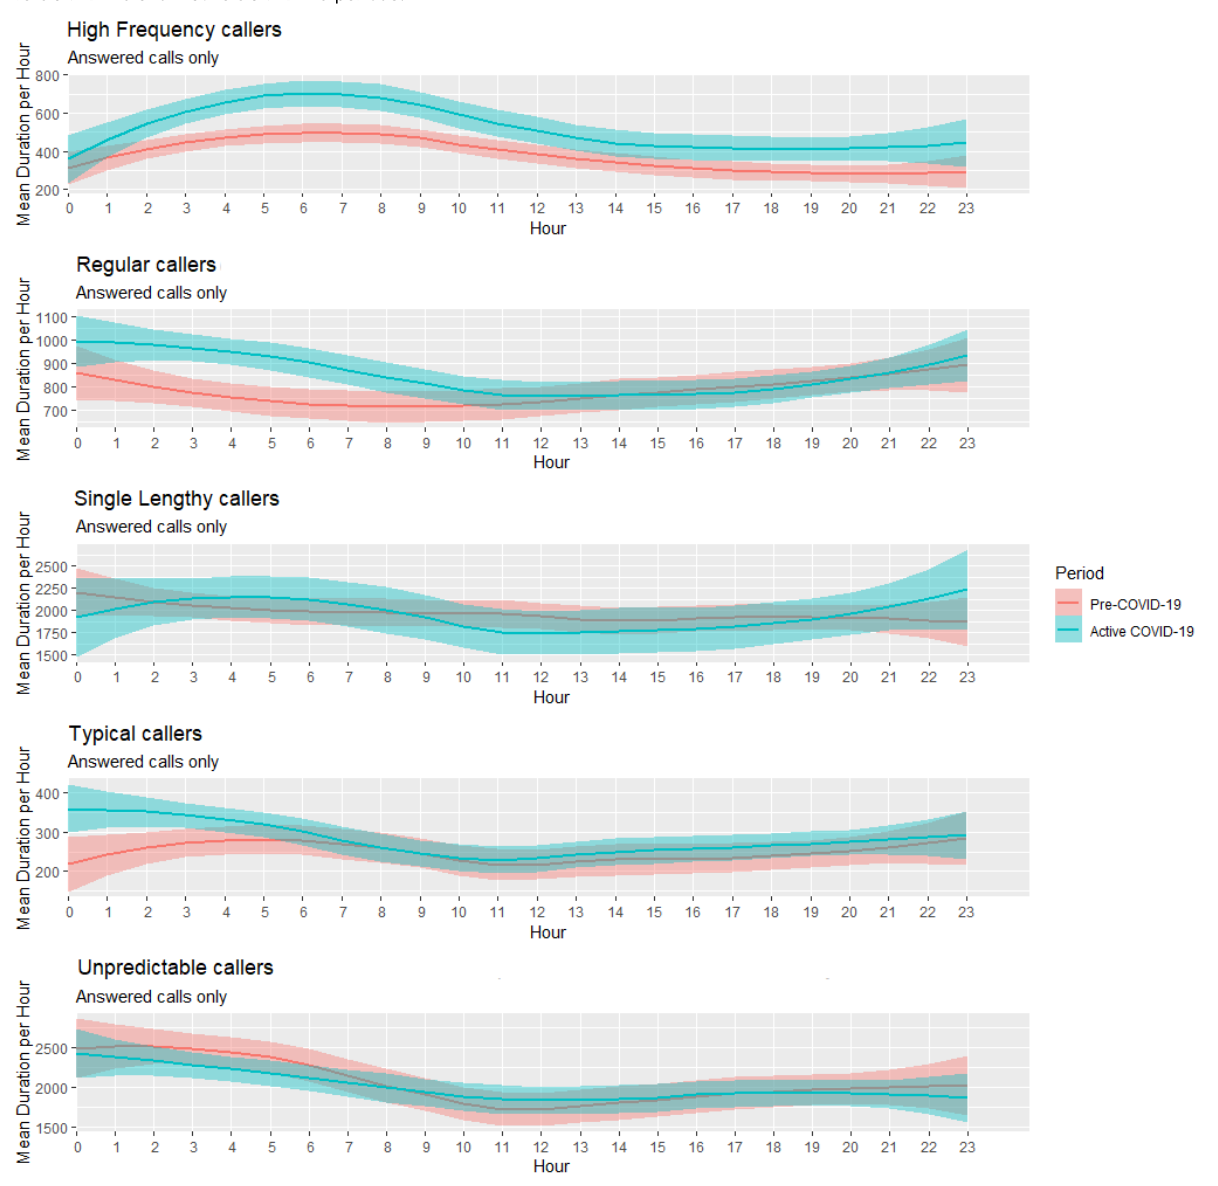
Figure 5. Smoothed conditional means plots displaying the mean call durations in seconds for the five caller types across a 24-hour period between the Pre-COVID-19 and Active COVID-19